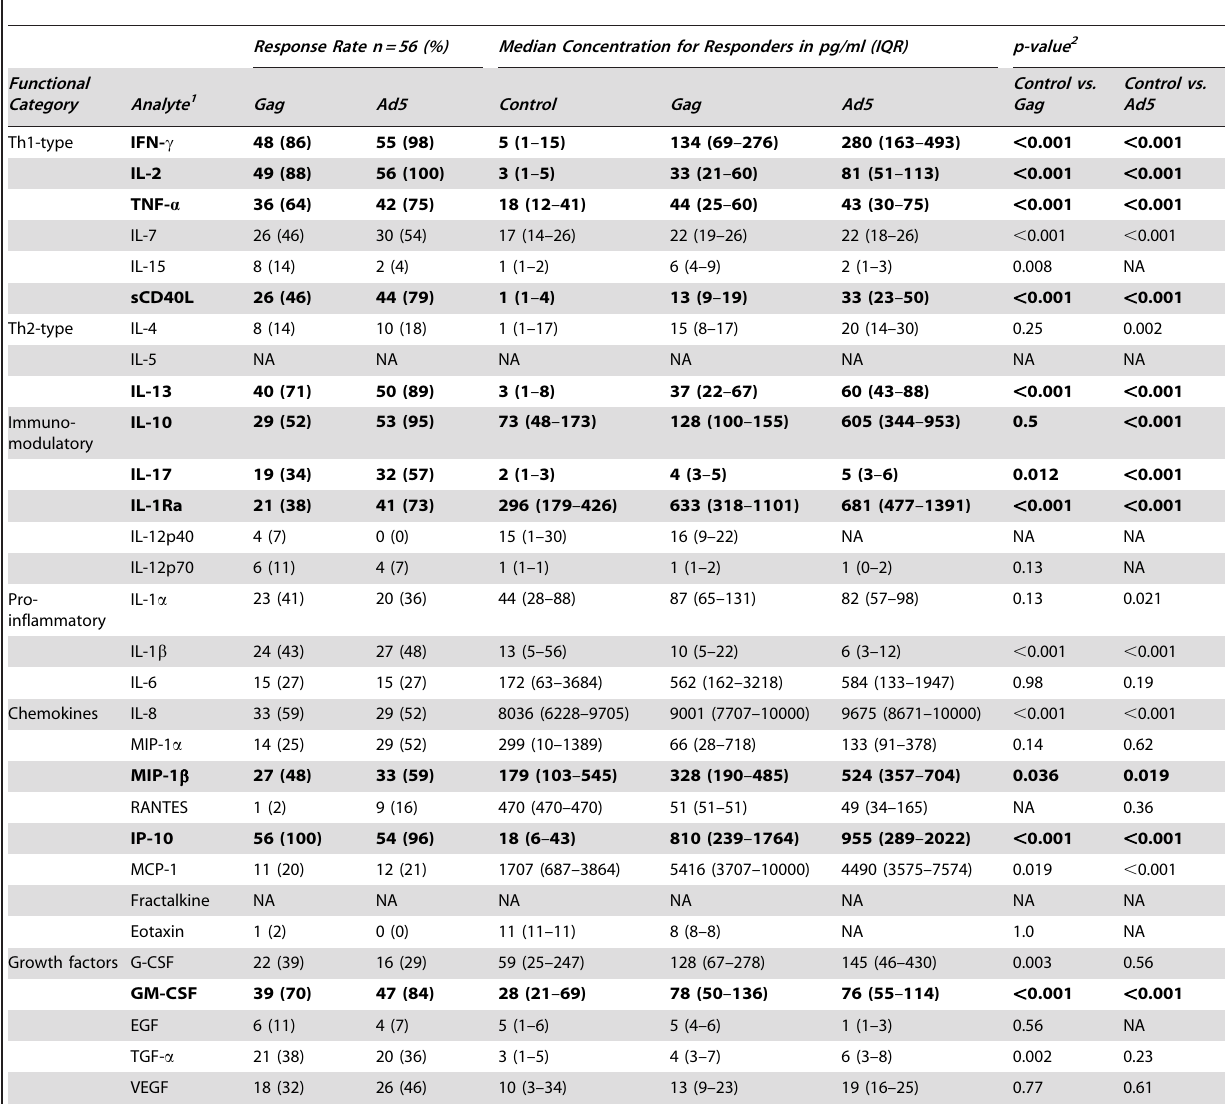
Table 2. Response rate and magnitude of response to Gag peptides or Ad5 empty vector at peak timepoint after three vaccine